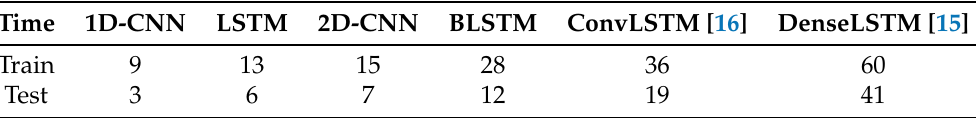
Table 3. Consumed-time (milliseconds per step) comparison for different